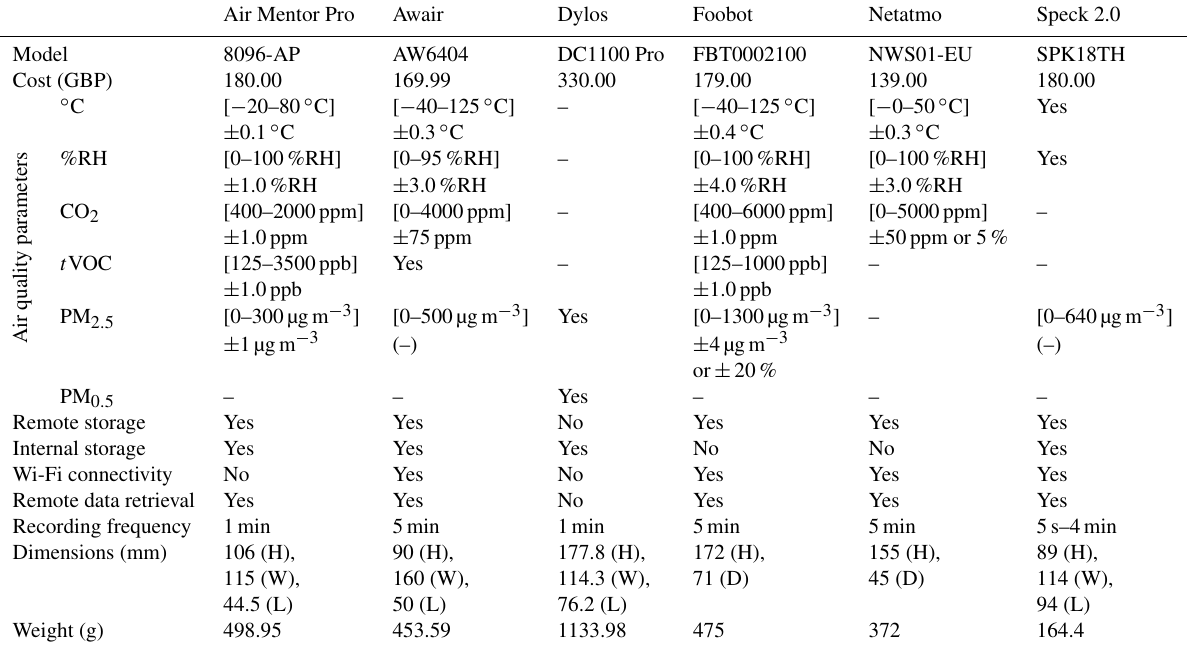
Table 1. Manufacturer specifications and characteristics for the low-cost consumer